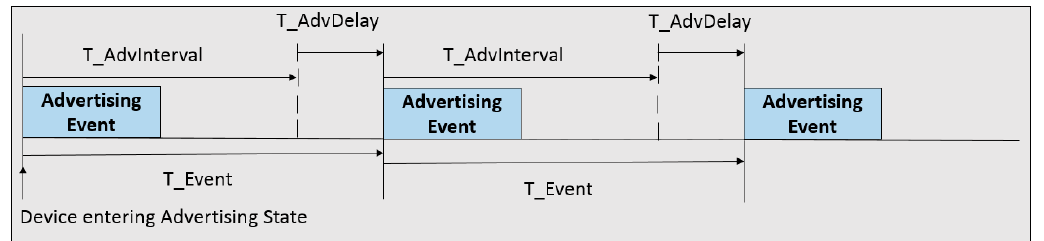
Figure 1. Timing specifications for an advertising event.